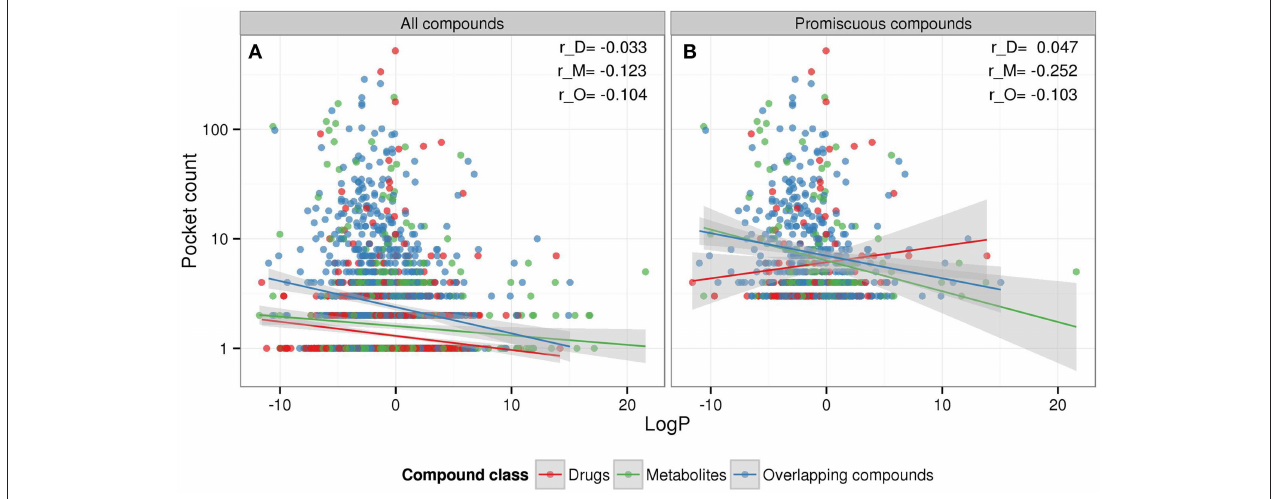
FIGURE 3 | Compound-type specific relationships between hydrophobicity (logP) and promiscuity (pocket count). The scatter plots show the three compound classes drugs (red), metabolites (green), and overlapping compounds (blue) including their linear regression curves and 95% confidence region (gray) for (A) both selective and promiscuous compounds together and (B) promiscuous compounds only with at least three non-redundant target pockets. Corresponding Pearson correlation coefficients for drugs (r_D), metabolites (r_M), and overlapping compounds (r_O) are also